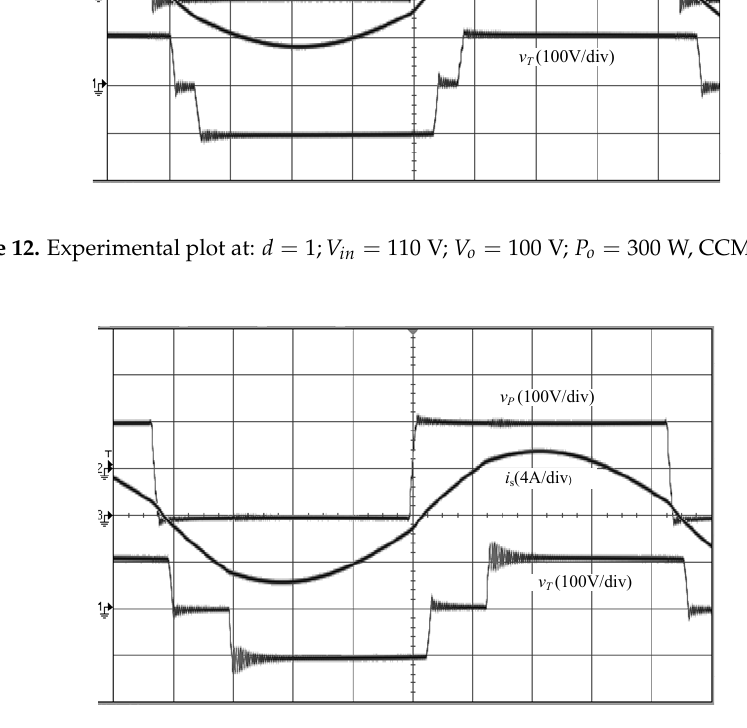
Figure 13. Experimental plot at: d > 1; V in = 100 V; V o = 100 V; P o = 300 W, CCM1 operation.